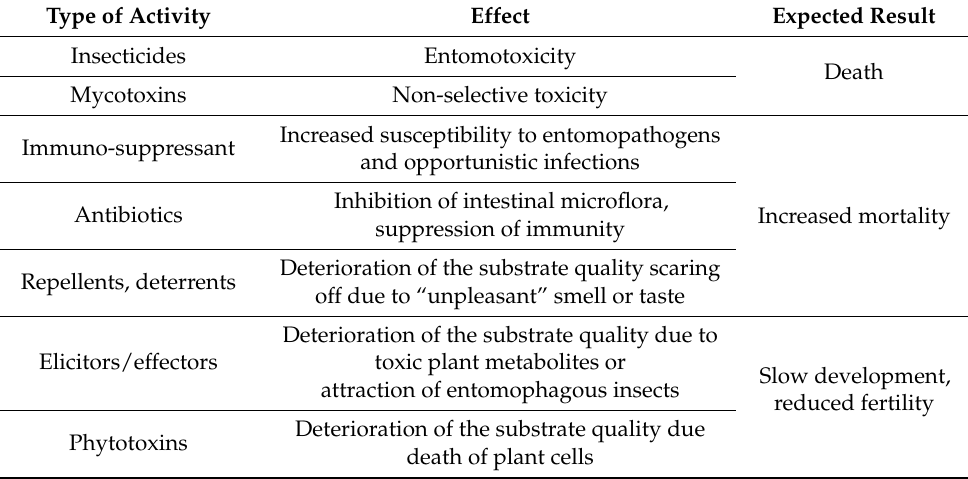
Table 3. Fungal metabolites with antagonistic action against